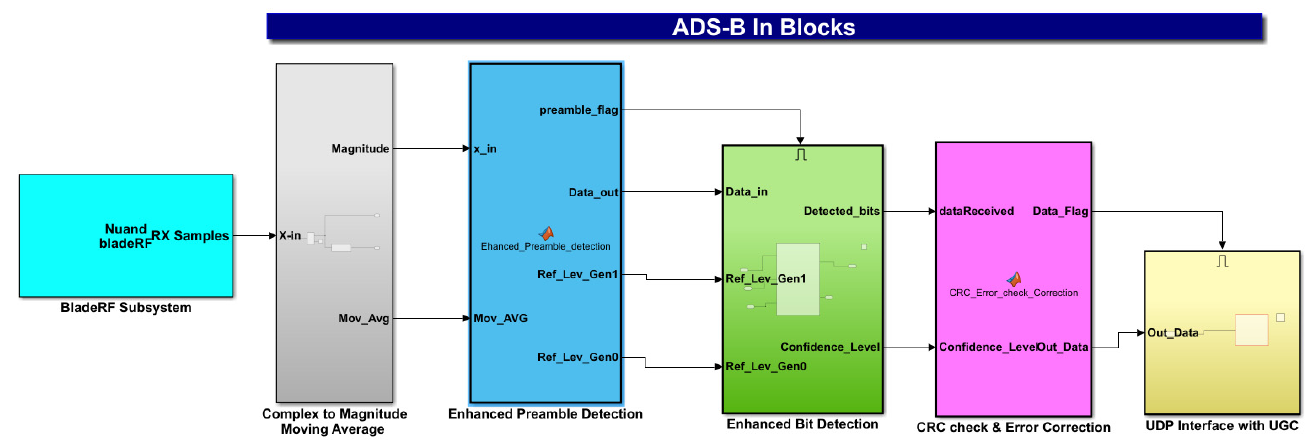
Figure 8. ADS-B In's simulation. Figure 8. ADS-B In’s simulation.